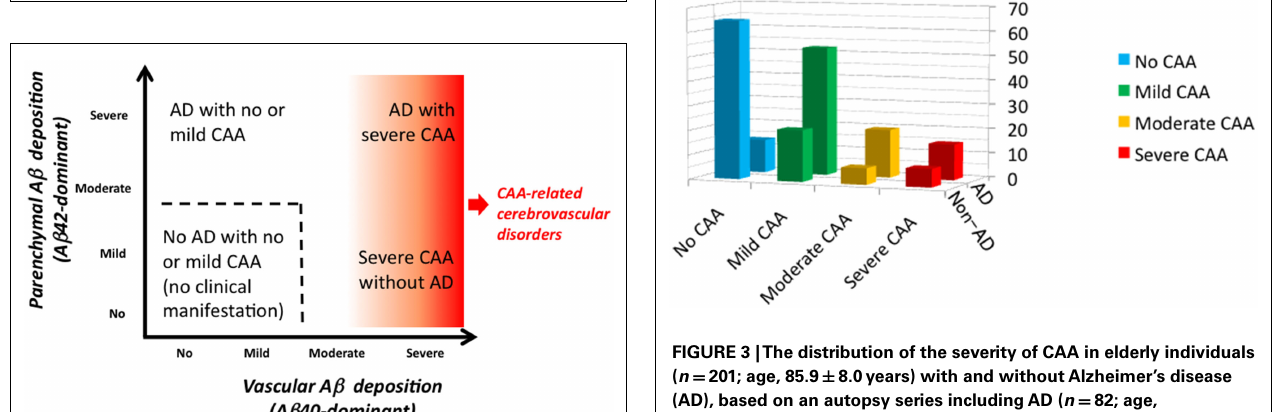
FIGURE 1 | Pathophysiology of cerebral amyloid angiopathy (CAA)-related disorders. A β shows parenchymal or vascular deposition, depending on dominance of A β 42 or A β 40, respectively, in elderly individuals and patients with Alzheimer’s disease (AD). Cerebrovascular amyloid deposition, CAA, is related to stroke and dementia.